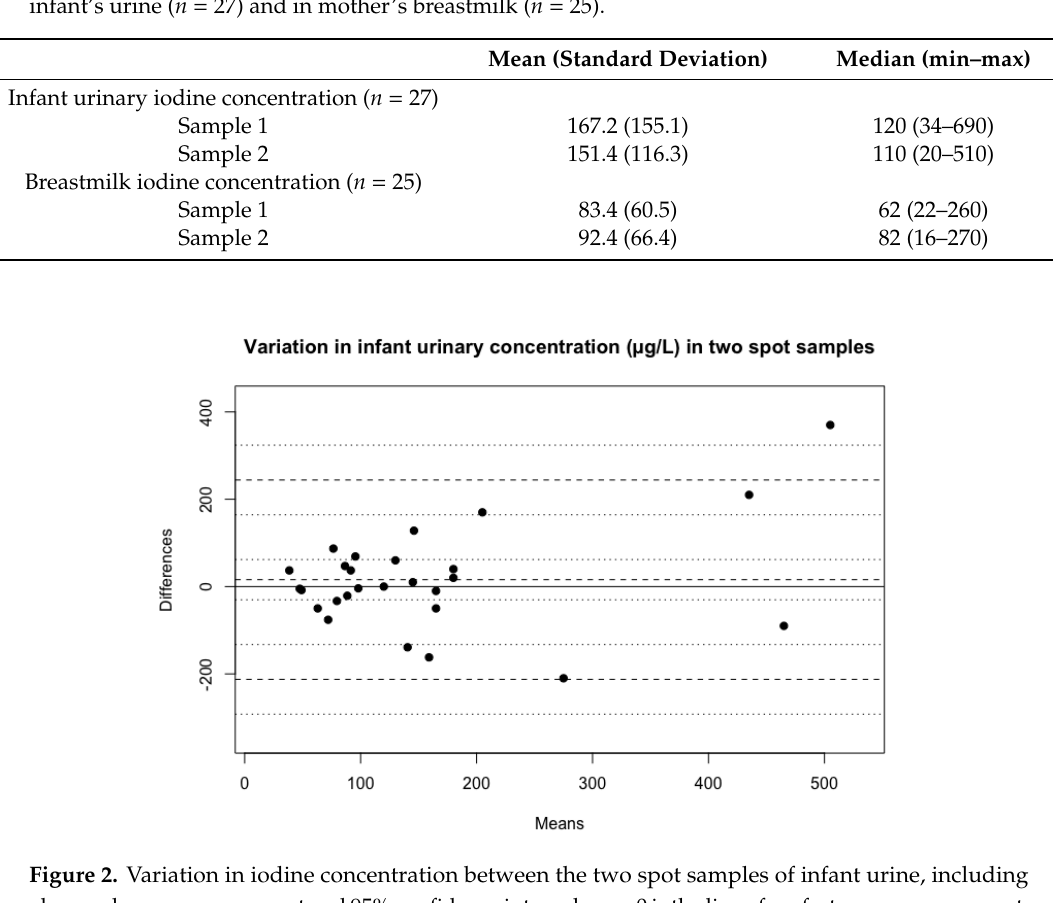
Table 2. Mean and median iodine concentration (µg/L) measured in two sets of samples from the